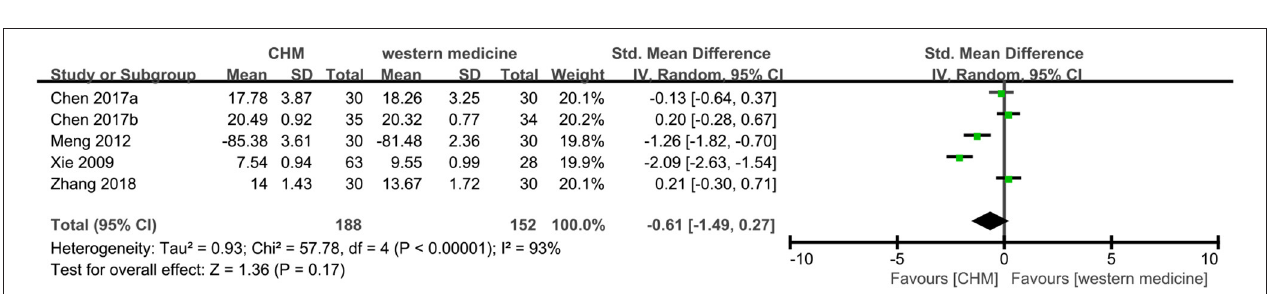
FIGURE 10 | Forest plot of comparison: CHM vs. western medicine, outcome: ADL.